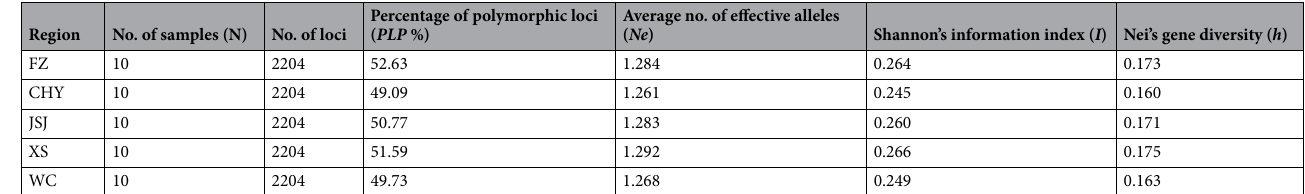
Table 3. Epigenetic diversity index values of rice in different regions. Ne Number of effective alleles, I Shannon’s information index, h Nei’s gene diversity.